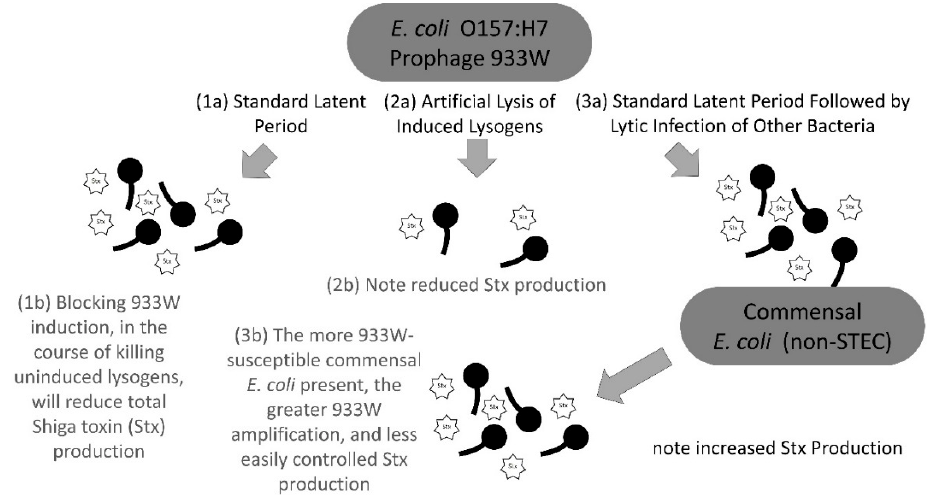
Figure 4. Different routes towards Shiga toxin (Stx) release: (1) 933W prophage induction followed by normal lytic cycles; (2) artificial lysis, for example by exogenous phage, of induced lysogens, resulting in truncated lytic cycles; and (3) subsequent lytic infection of non-Shiga toxigenic E. coli strains giving rise to more lytic cycles. Greater Stx production (stars in the figure) can occur given artificial induction of E. coli O157:H7 lysogens, but this both is not explicitly illustrated in the figure and is distinct from artificial lysis of already induced lysogens (2). Given the linkage between 933W induction and Shiga toxin production, the killing of E. coli O157:H7 lysogens without inducing the 933W prophage should result in reductions in future 933W induction events (Figure 3 and Table 2) along with subsequent reductions in Shiga toxin production.